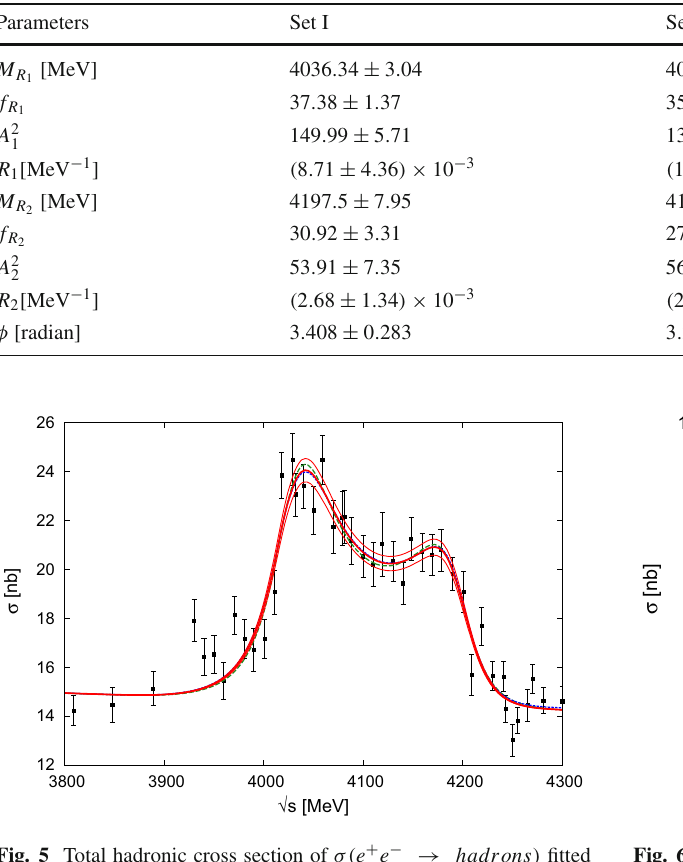
Fig. 5 Total hadronic cross section of σ( e + e − → hadrons ) fitted to the experimental data from Fig. 1 in Ref. [13]. The solid red line correspondstheparametersSetI,dashedgreenlineSetIIanddottedblue line Set III. The most extreme thin lines provide the band of uncertainty of the fit evaluated as explained in the tex